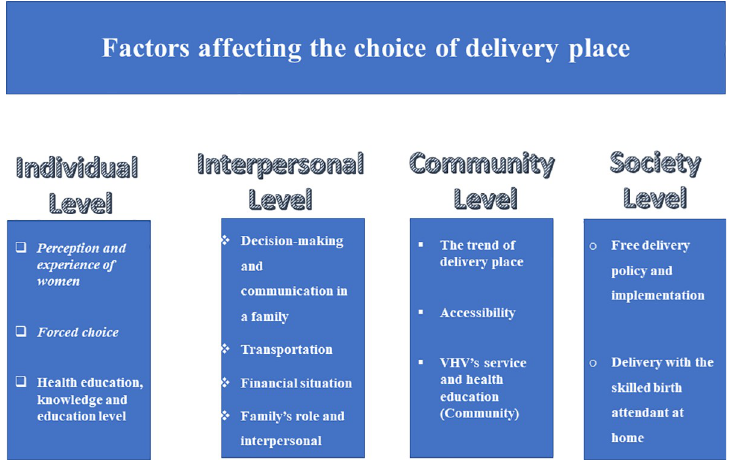
Fig 2. Summary of the factors affecting the choice of delivery place in a rural area in